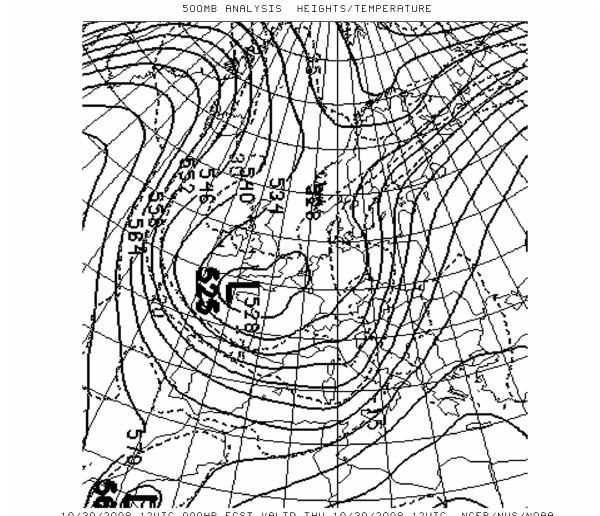
Fig. 3. MOLOCH domain of integration, topography and land-sea mask. Contour interval 250m. The thick straight lines identify the location of the cross-sections shown in Figs. 9–12.